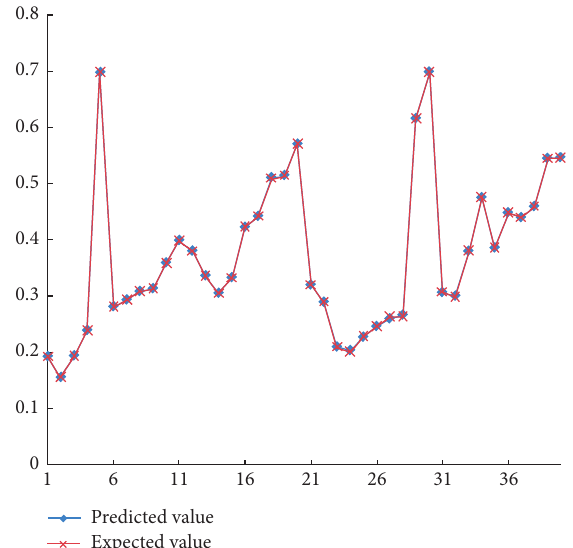
Figure 1: Fitting curve of the TOPSIS-BP neural network model.